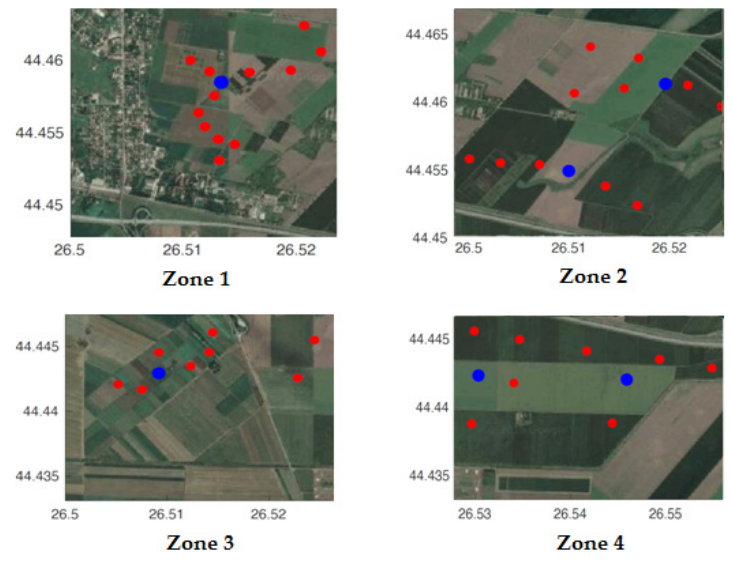
Figure 15. Location of nodes in four zones.